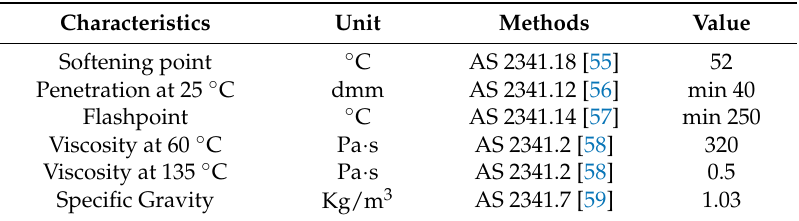
Table 2. Characteristics of the original